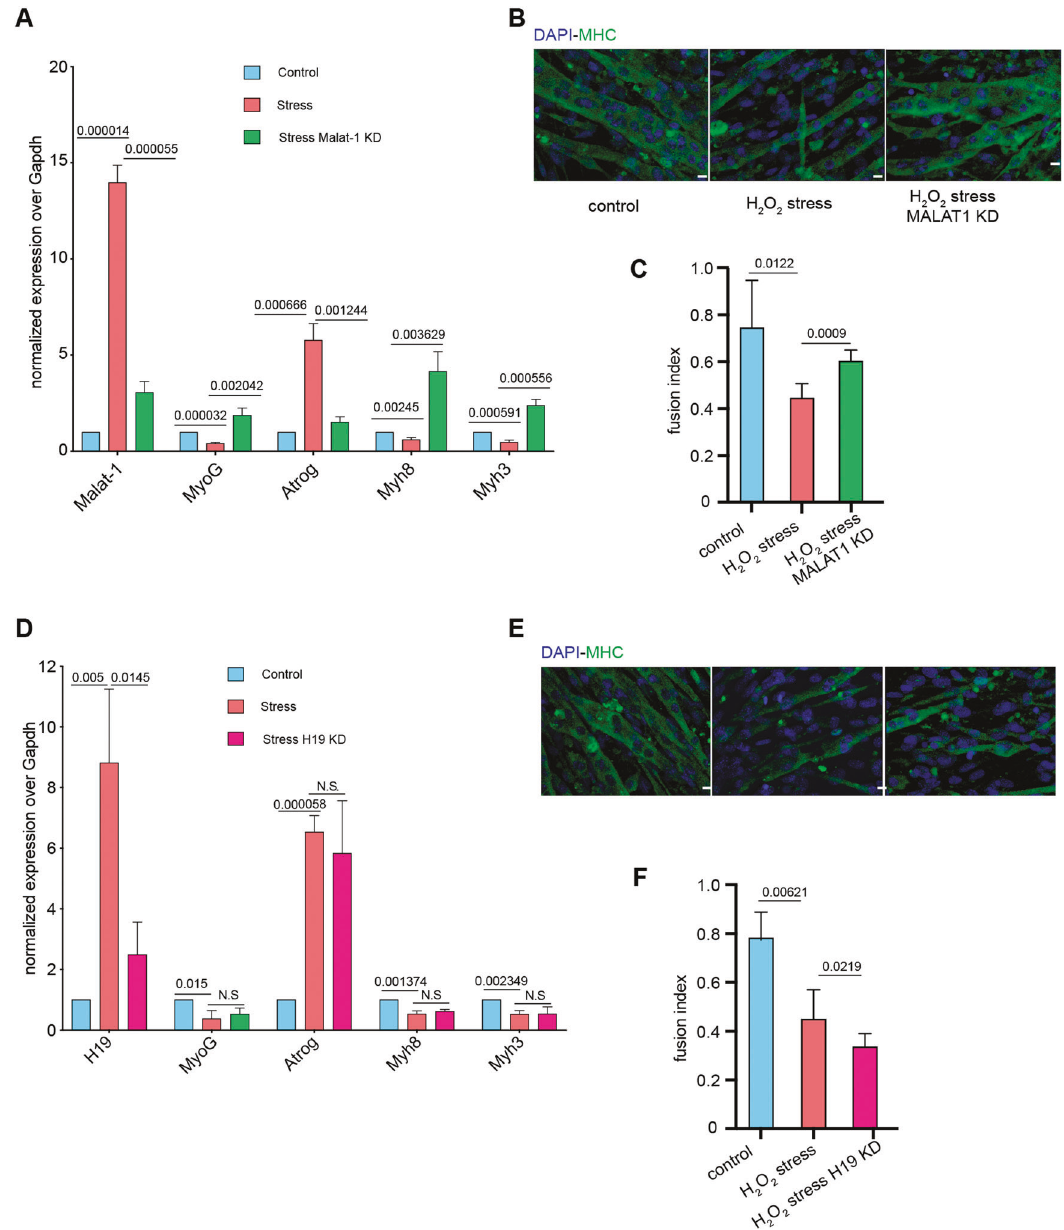
Fig. 4 Malat-1 depletion restores skeletal muscle gene expression and myotube fusion capacity under stress condition. A RT-qPCR analysis of transcription levels of Malat-1 , MyoG , Myh8 , Myh3 , and Atrog under indicated conditions. Error bar represent mean ± SD ( n = 3) with t -test P -value shown on top of each graph. B Immuno fl uorescence staining of myosin heavy chain (MYHC-green) at day 4 of differentiation. Nuclei were counterstained with DAPI (blue). C Fusion index analysis indicate number of nuclei in multi-nucleated myotubes, de fi ned by at least three nuclei, divided by the total number of nuclei in the same fi eld. Minimum four fi elds at ×40 magni fi cation per replicate were counted from each experiment (~400 – 500 nuclei). Error bar represents mean ± SD ( n = 3) with t -tests P -value shown on top of each graph. D RT-qPCR analysis of transcription levels of H19 , MyoG , Myh8 , Myh3 , and Atrog under indicated conditions. Error bar represents mean ± SD ( n = 3) with t -test P -value shown on top of each graph. E Immuno fl uorescence staining of myosin heavy chain (MYHC-green) at day 4 of differentiation. Nuclei were counterstained with DAPI (blue). F Fusion index analysis indicate number of nuclei in multi-nucleated myotubes, de fi ned by at least three nuclei, divided by total number of nuclei in the same fi eld. Minimum four fi elds at ×40 magni fi cation per replicate were counted from each experiment (~400 – 500 nuclei). Error bar represent mean ± SD ( n = 3) with t -tests P -value shown on top of each graph. temperature 1× phosphate-buffered saline (PBS). Each 5 × 10 6 cells were frozen pellets were then resuspended in a 1 ml RIPA lysis buffer (50 mM resuspended in 1 ml of media without FBS or high salt (HS). We then added Tris pH 8.0, 150 mM KCl, 0.1% SDS, 1% Triton X-100, 5 mM EDTA, and 0.5% formaldehyde (Sigma) of a fi nal concentration of 0.1%. Crosslinking was sodium deoxycholate, supplemented with freshly prepared 0.5 mM done for 10 min at room temperature. Quenching was performed using dithiothreitol (DTT), 1× EDTA protease inhibitor cocktail (Roche), and glycine added to a fi nal concentration of 125 mM. The cells were spun 100 U/ml RNaseOUT (Life Technologies, 10777 – 019)) per tube. The cells again for 5 min at 500 RCF, then washed twice using cold PBS. The pellets were incubated at 4 °C for 10 min, then lysed with a Branson ® digital were fl ash frozen in liquid nitrogen and stored at − 80 °C for later use. The sonicator using 10% amplitude for 0.7 s ON and 1.3 s OFF at 30 s intervals Cell Death and Disease (2021)